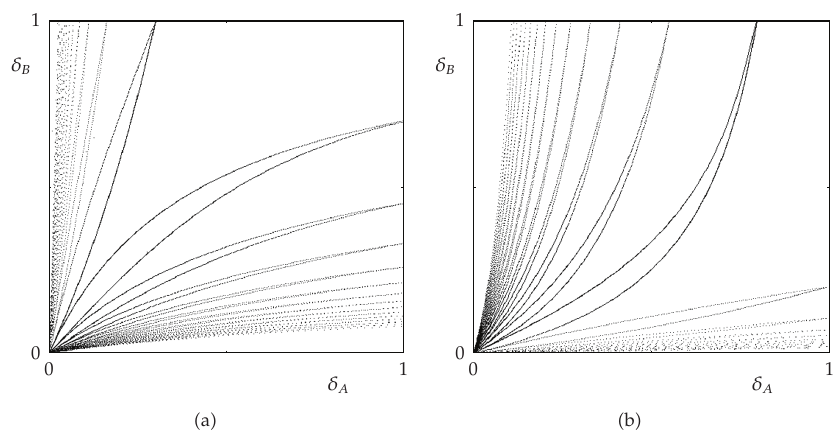
Figure 13: Bifurcation curves of the principal tongues of period k , with k (cid:7) 2 ,..., 15 (cid:2) a (cid:3) d (cid:7) 0 . 3; (cid:2) b (cid:3) d (cid:7) 0 .